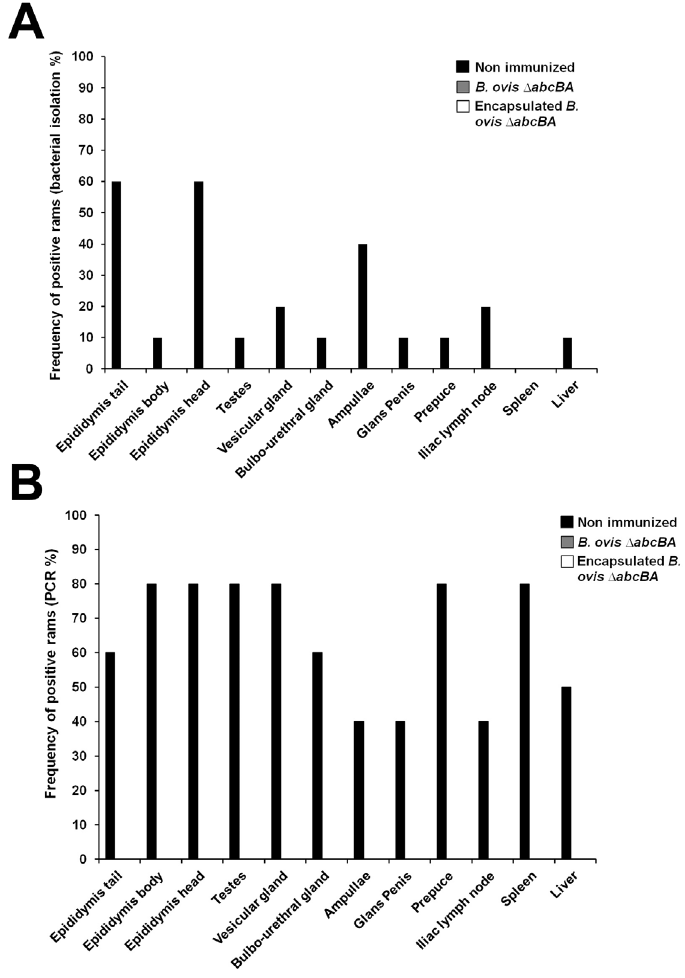
eight weeks post experimental challenge with wild type B . ovis